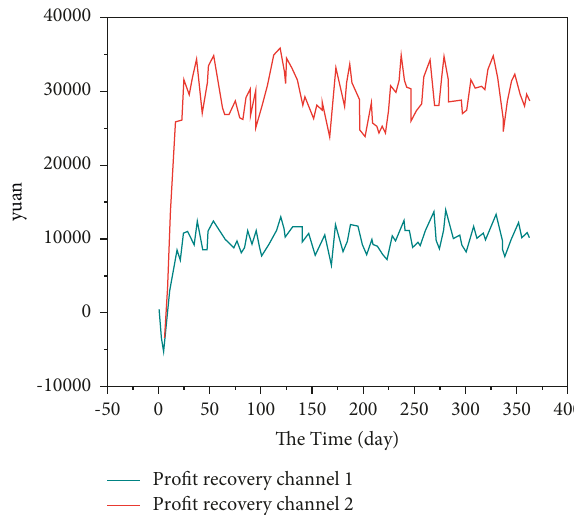
Figure 13: Recovery profit comparison. Table 3: Simulation of part of the time recovery profit